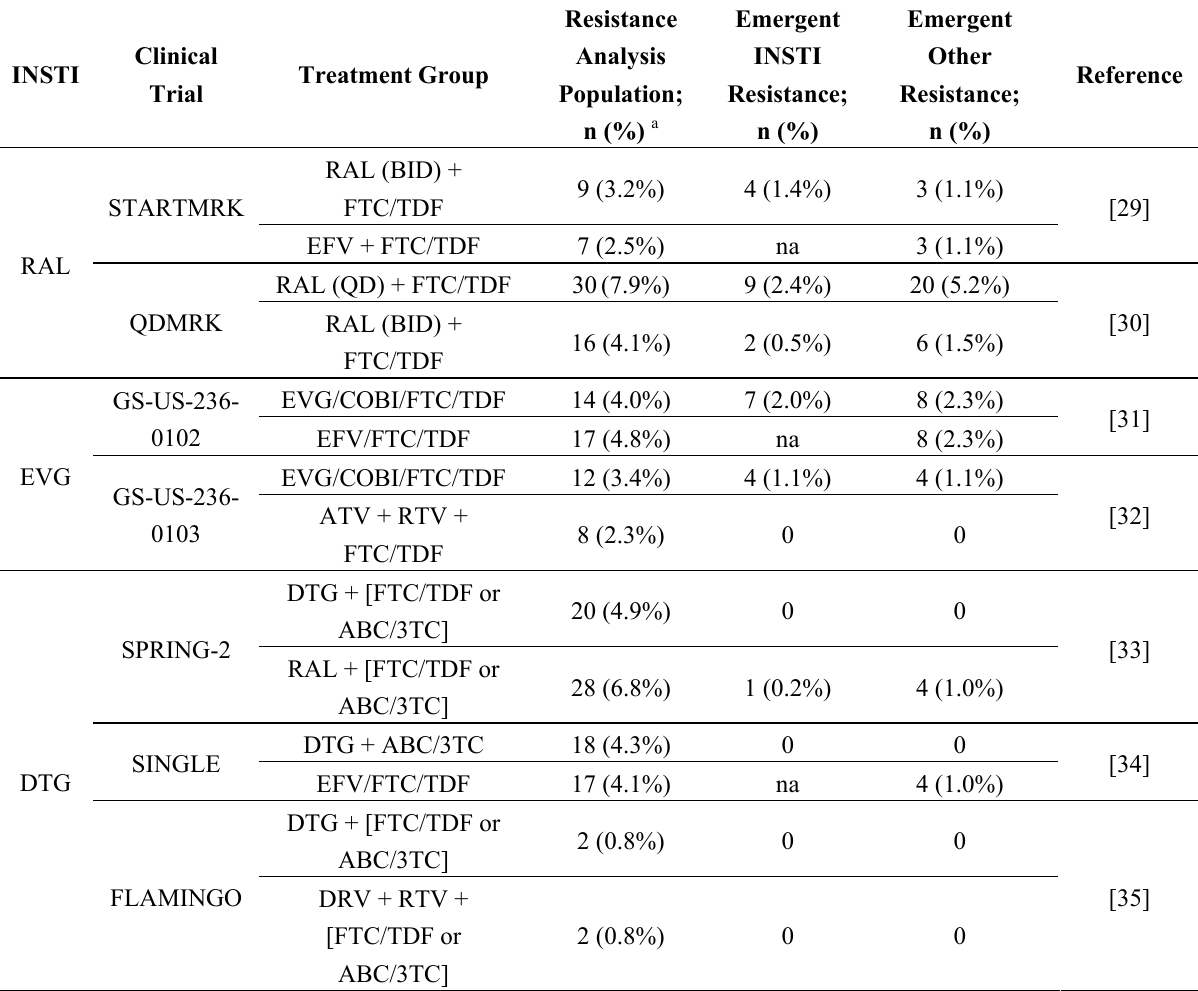
Table 3. Resistance development in INSTI clinical